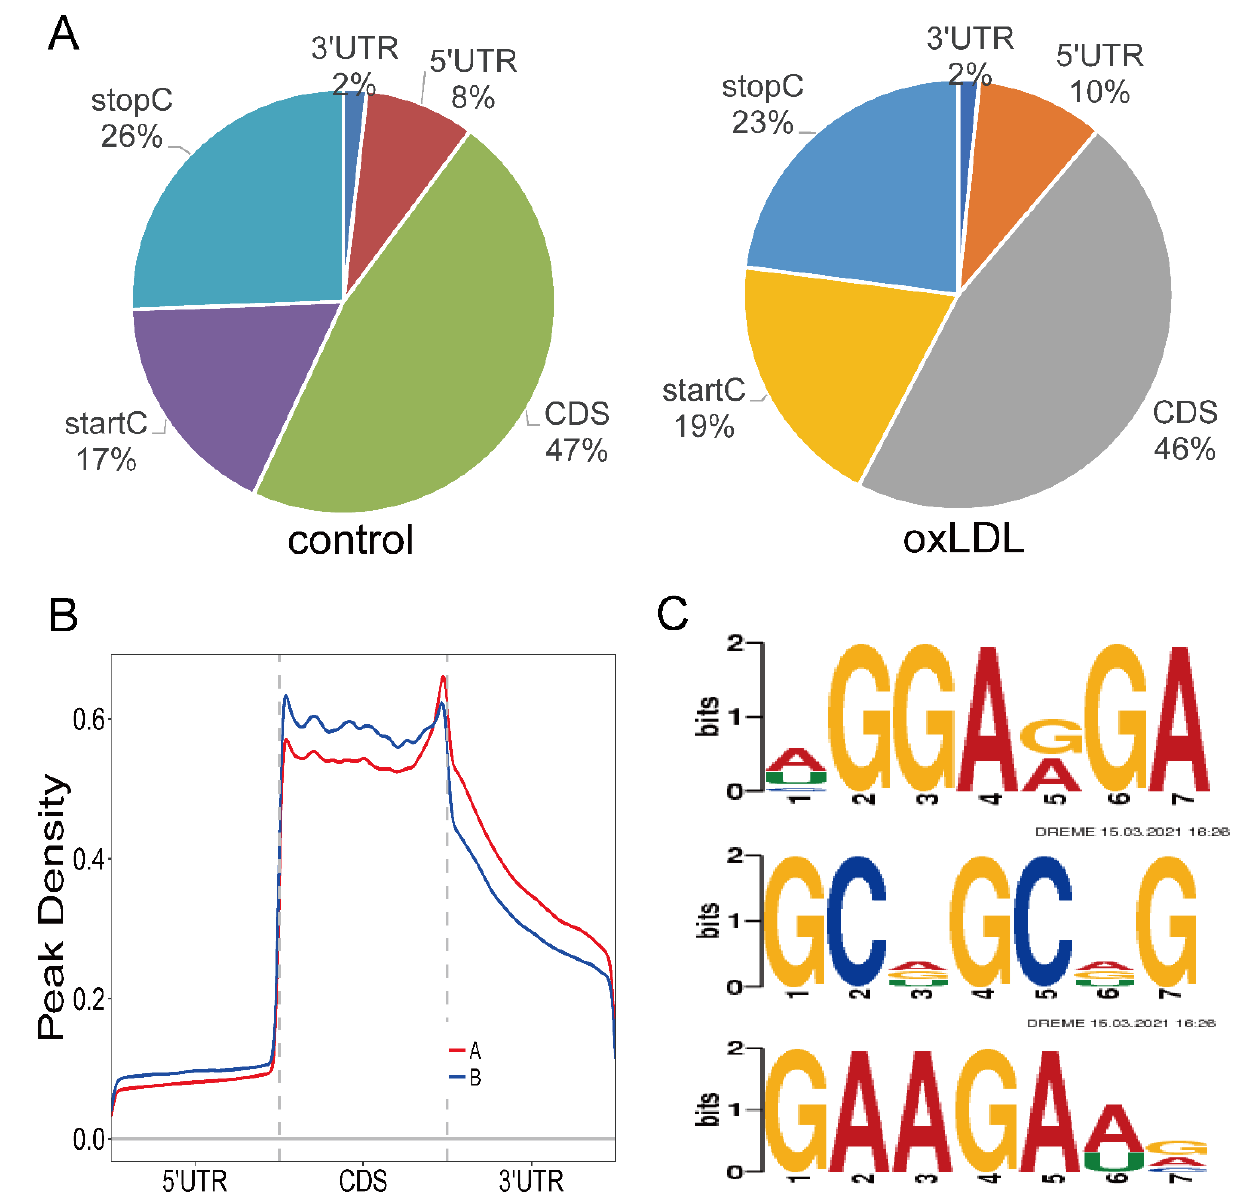
Figure 2. Analysis of sources of mRNA methylation and motif analysis: ( A ) Pie charts showing m6A peaks’ distribution in different gene contexts. ( B ) Preferential location of m6A in mRNA. Each transcript is divided into three parts, including a 5 ’ untranslated region, coding DNA sequence, and 3 ’ untranslated region. ( C ) The top three motifs enriched across m6A peaks identified from the experimental group.